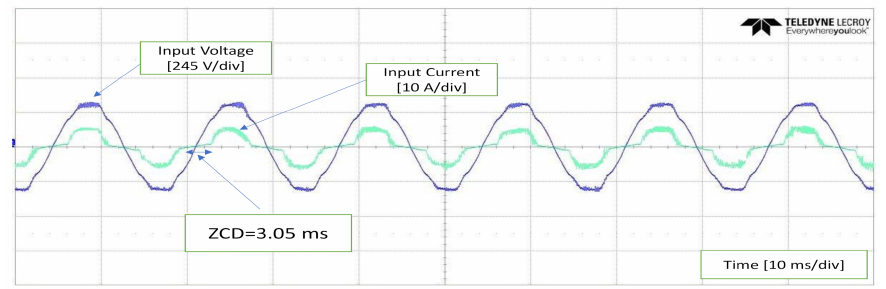
Figure 38. Experimental waveforms of the supply voltage-current with the proposed IP current controller at 25% loading